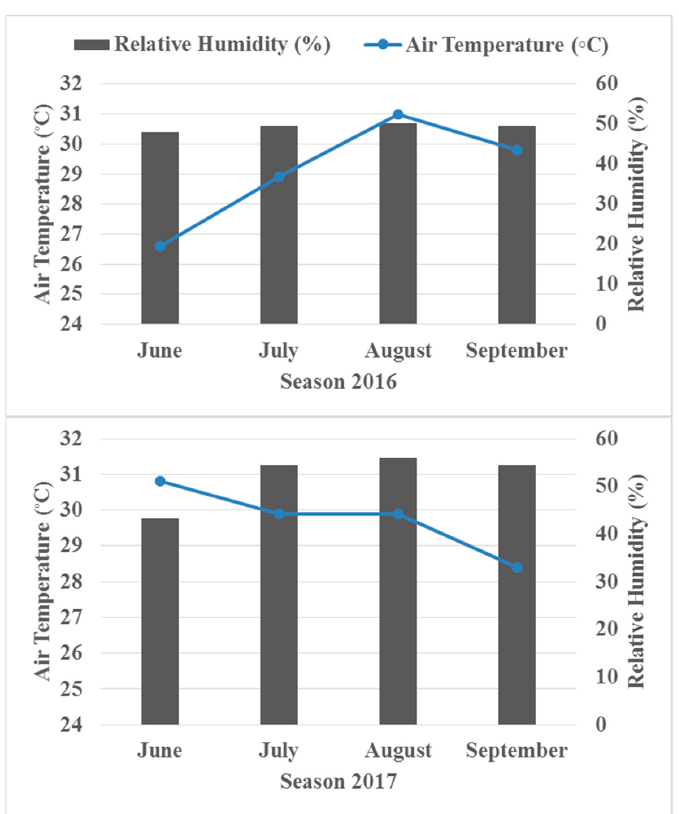
Figure 1. Monthly average of air temperature, relative humidity and precipitation level during 2016 and 2017 seasons. Source: Central Laboratory for Agricultural Climate, Agricultural Research Center, Ministry of Agriculture & Land Reclamation, Egypt.